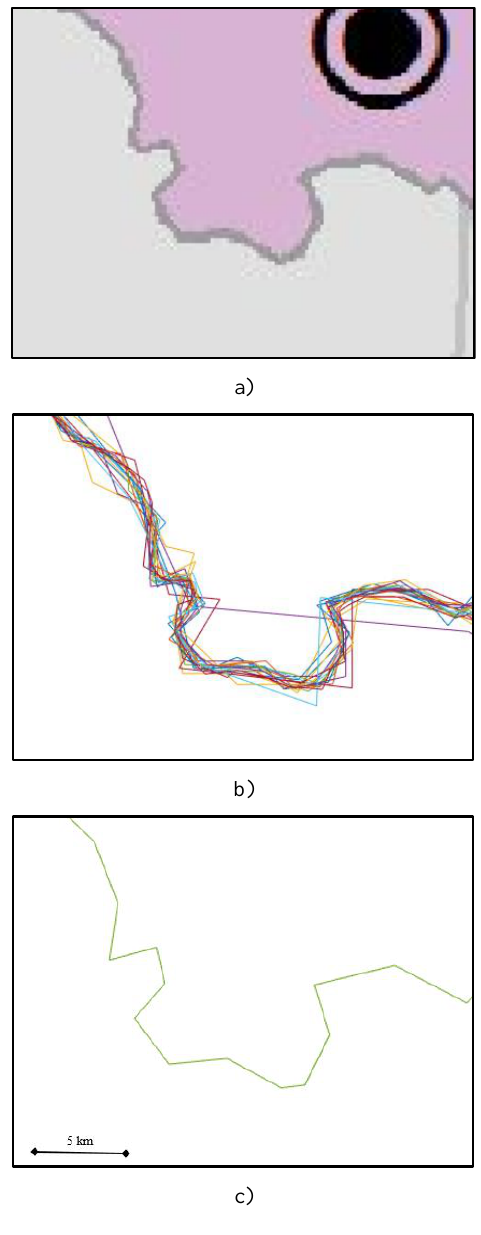
Figure 4. Used datasets: (a) Zoom-in into the data source that was used for data collection (b) Results of multiple data collection (c) Reference data